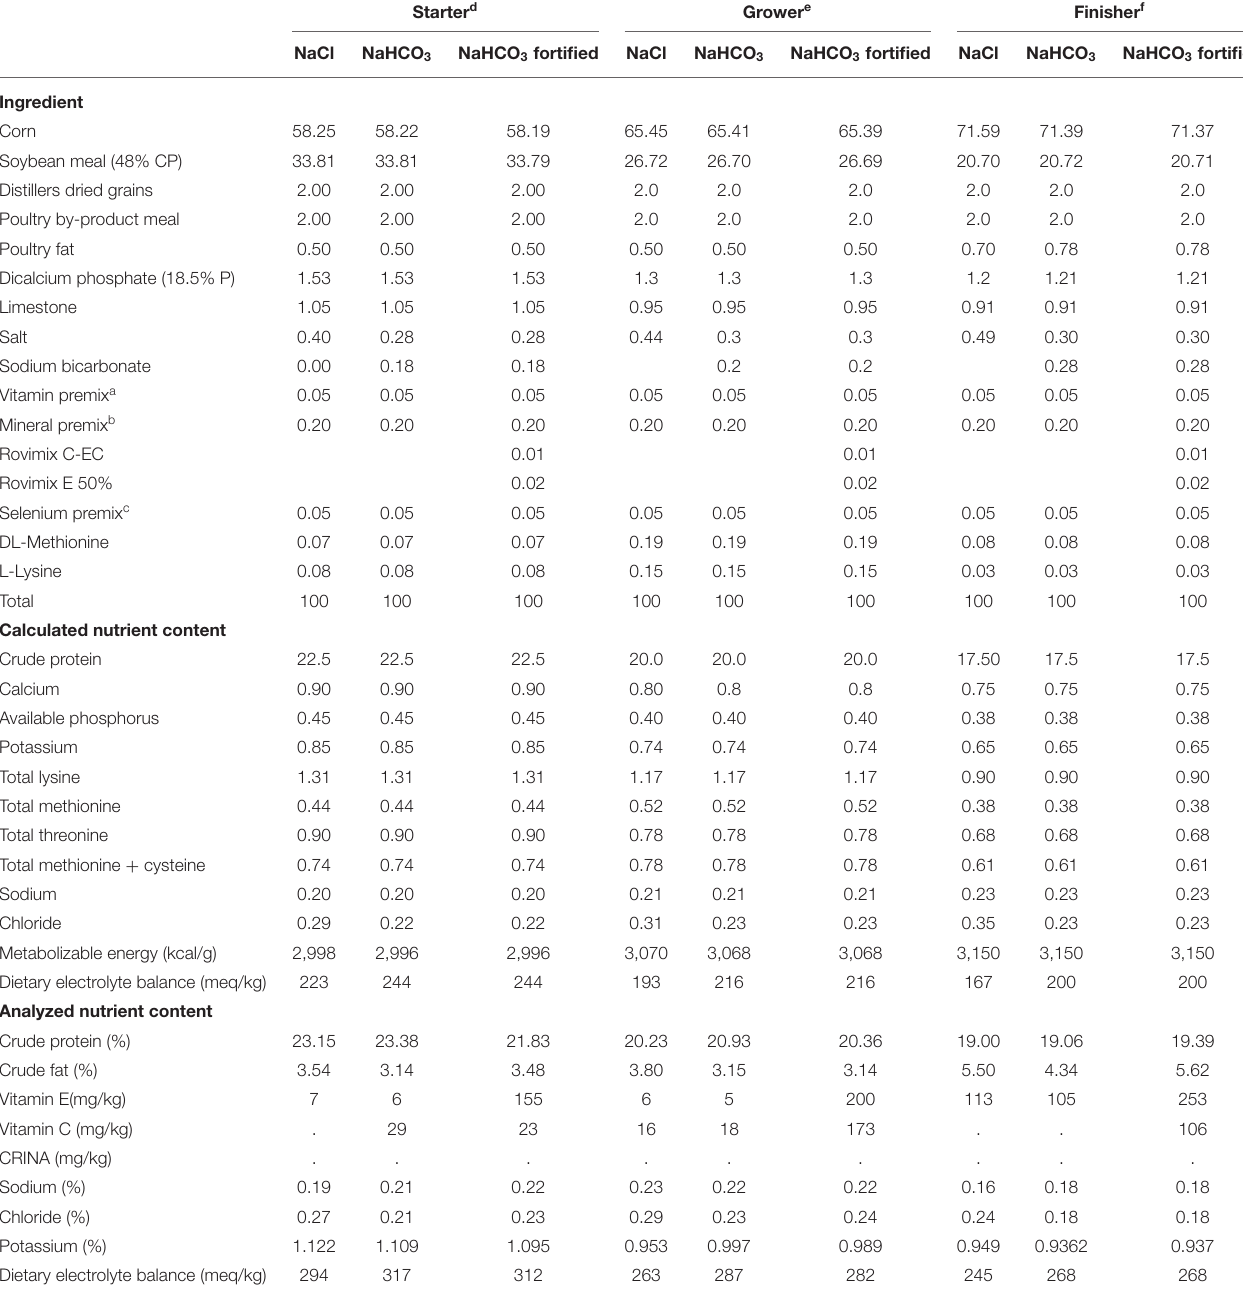
TABLE 1 | Composition of broiler starter, grower, and finisher diets. Starter d Grower e Finisher f NaHCO